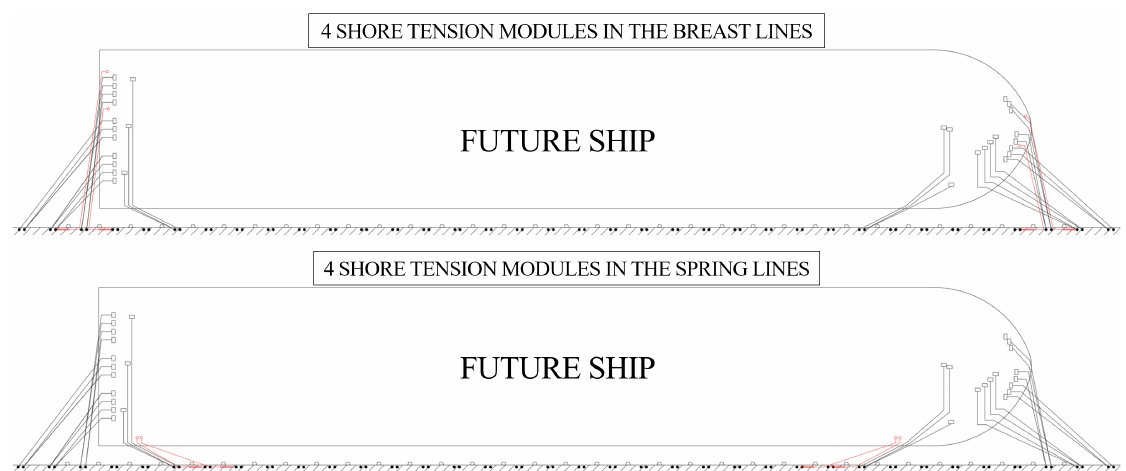
Figure 22. Position of the 60 t ShoreTension ® modules for the future vessel (red lines).